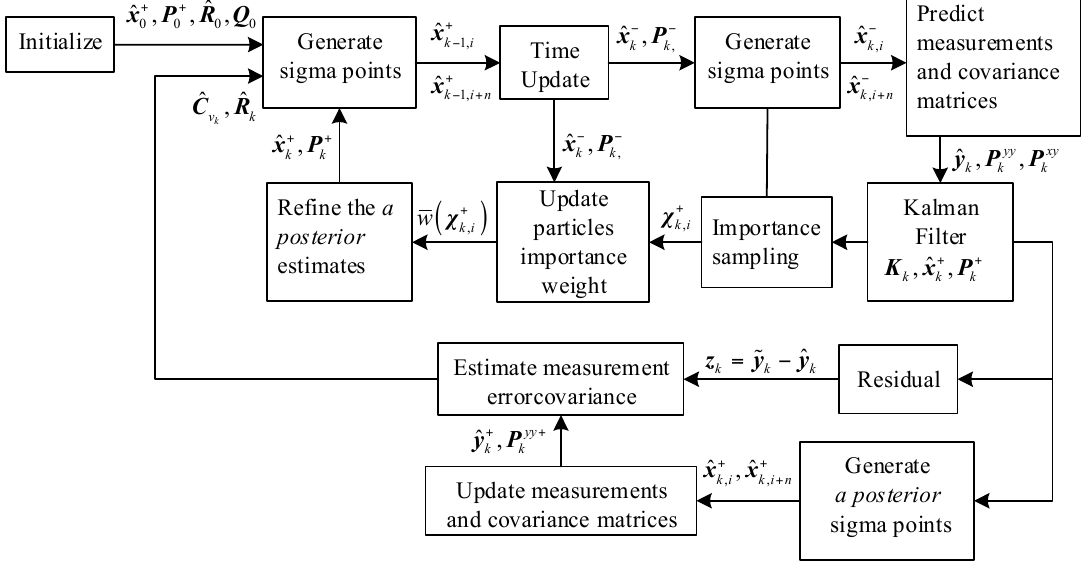
Figure 2. Adaptive unscented particle filter (AUPF) algorithm flowchart.